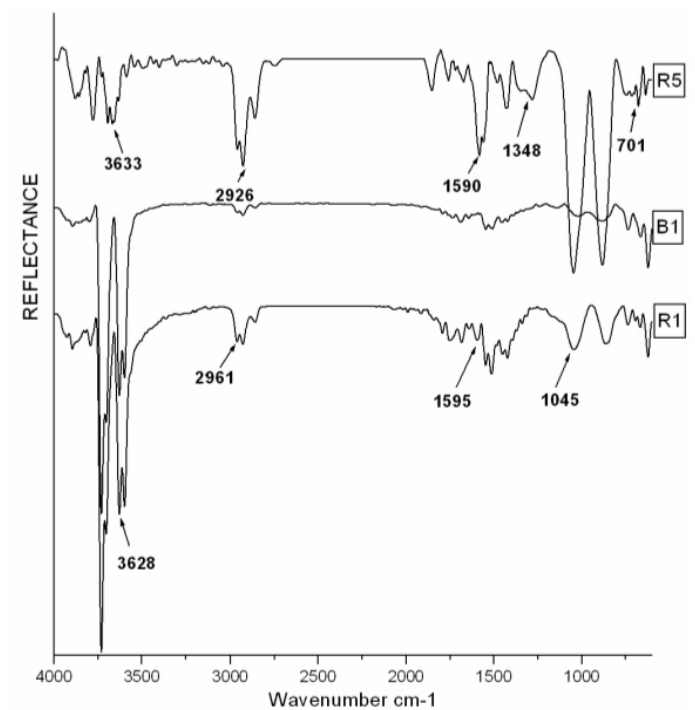
Figure 2. FTIR-VAR spectra of Romanite (R1) and Baltic (B1) geological amber overlaid with Romanite archaeological amber (R5), range 4000-600 cm -1 . Table 2. Differences between amber samples with controlled origin (geological) and from archaeological